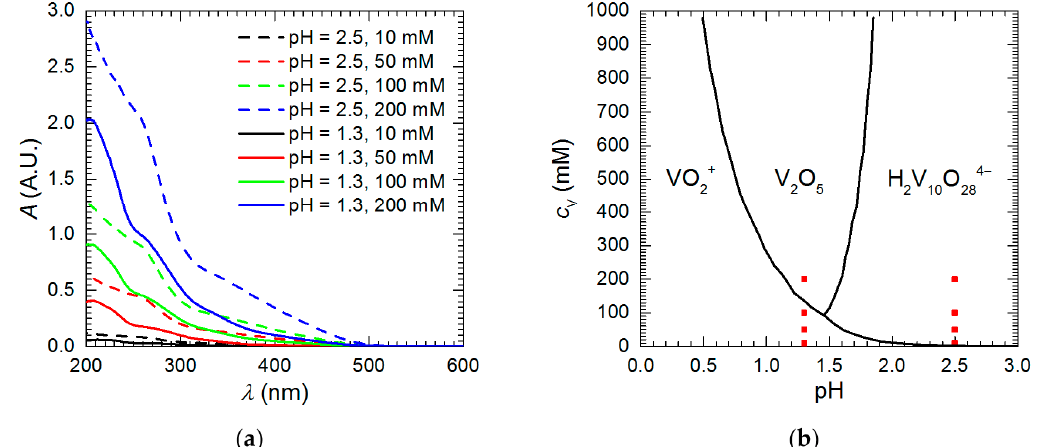
Figure 6. Vanadium speciation in the studied solutions: ( a ) UV-Vis absorption spectra recorded prior corrosion experiments for solutions diluted 300 times; ( b ) approximate distribution diagram of vanadium chemical species in acidic solutions prepared using data from [19], red points indicate chemical composition of solutions studied in this work.